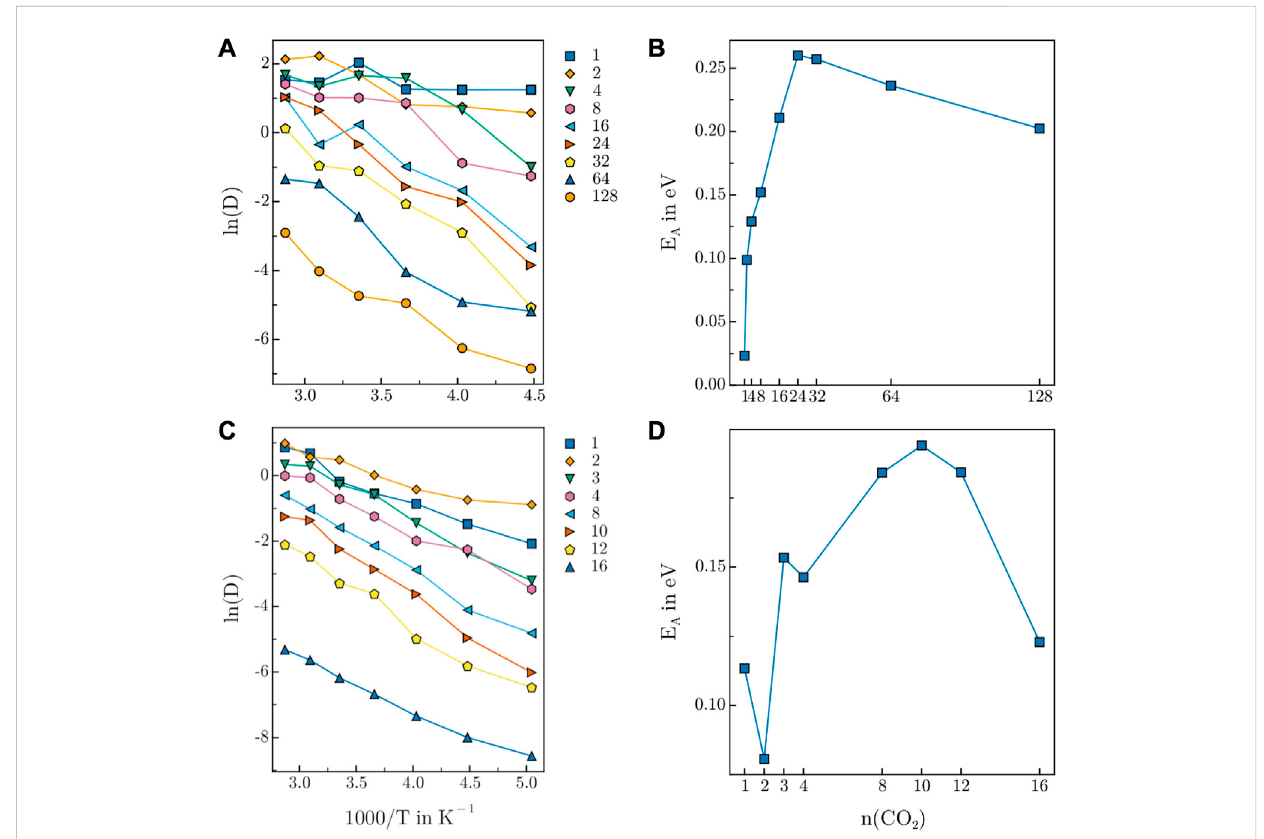
FIGURE 8 Arrhenius plot of CO 2 diffusion in (A) 3D-HNU5 and (B) HEX-COF1. Activationenergy of CO 2 diffusion in (C) 3D-HNU5 and (D) HEX-COF1. The CO 2 count in the legend of (C) and the label on the x-axis of (D) refers to the CO 2 content per